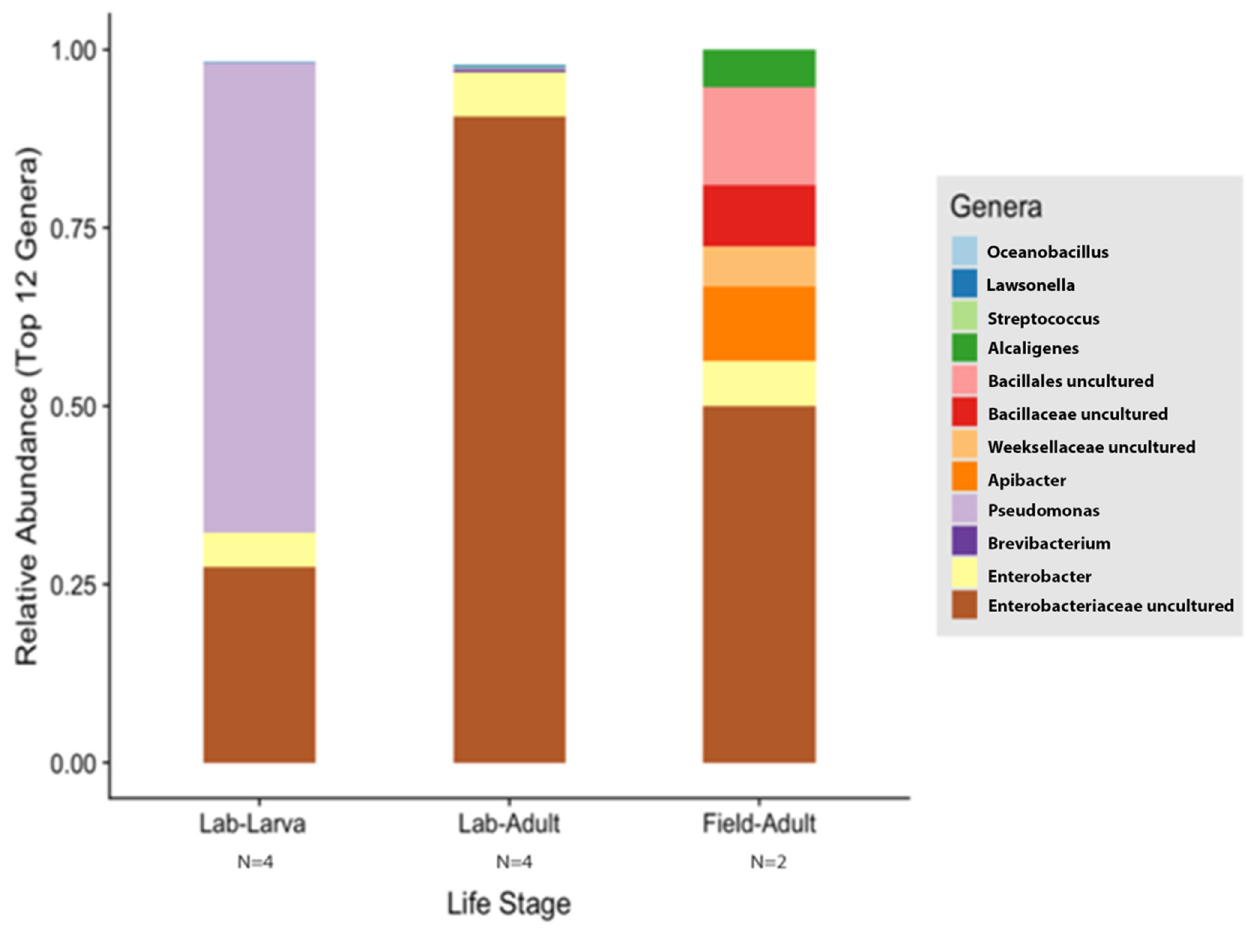
Figure 7. Comparison of laboratory-reared larvae and adults vs. field-collected adult gut microbiota composition of T. stercorea . Taxonomy graph comparing the relative abundance of genera present in T. stercorea . The 12 most abundance genera are shown.